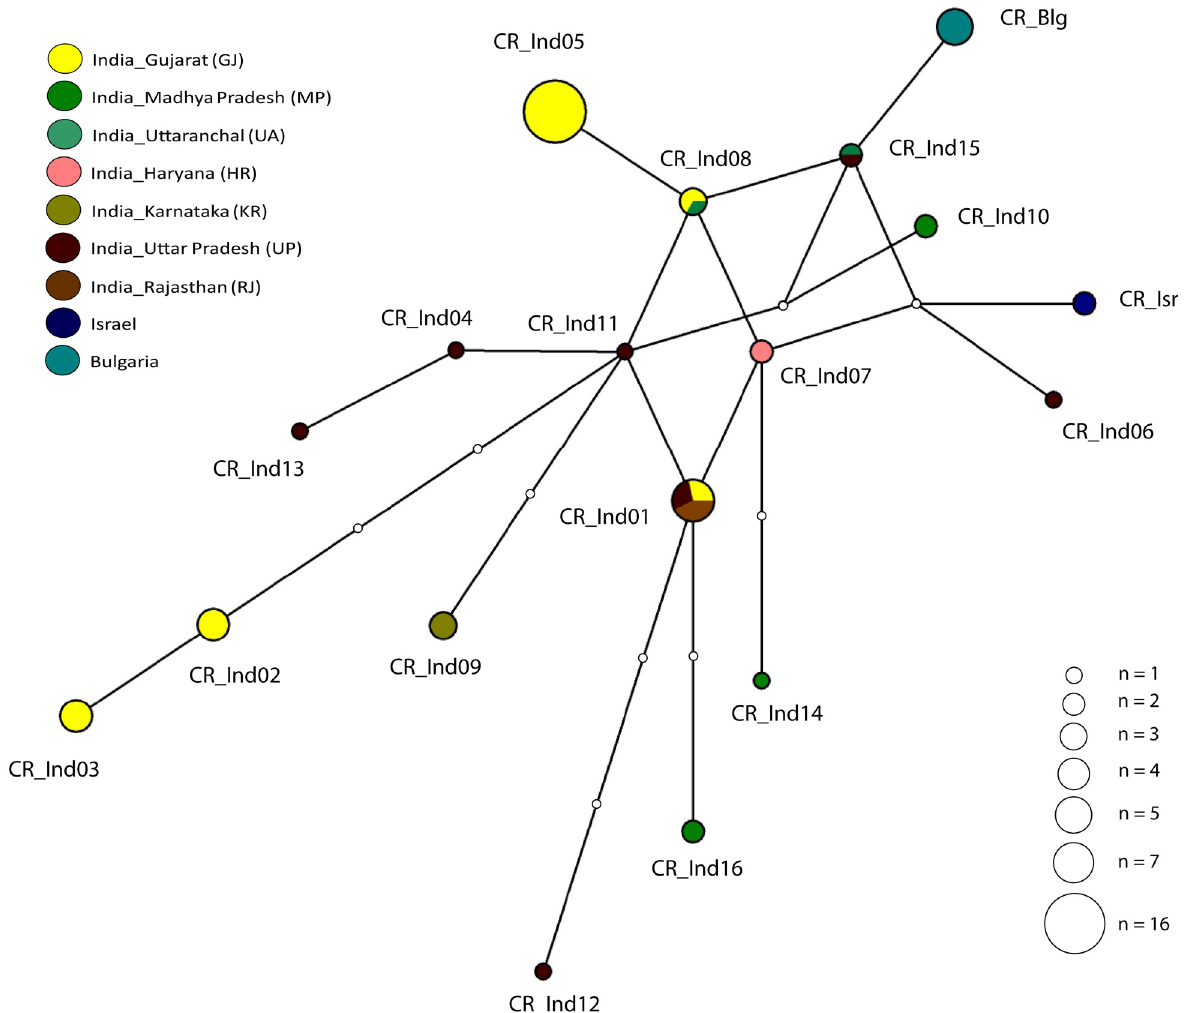
Fig 4. Median joining network of mtDNA CR (286 bp) haplotypes in golden jackals. Haplotype circle sizes are proportional to frequency, and colour coded according to geographic sampling area. Each node depicts a one base pair change. Variable nucleotide positions used in network construction are shown in Table 2. Circle sizes are proportional to the number of individuals represented by each haplotype.